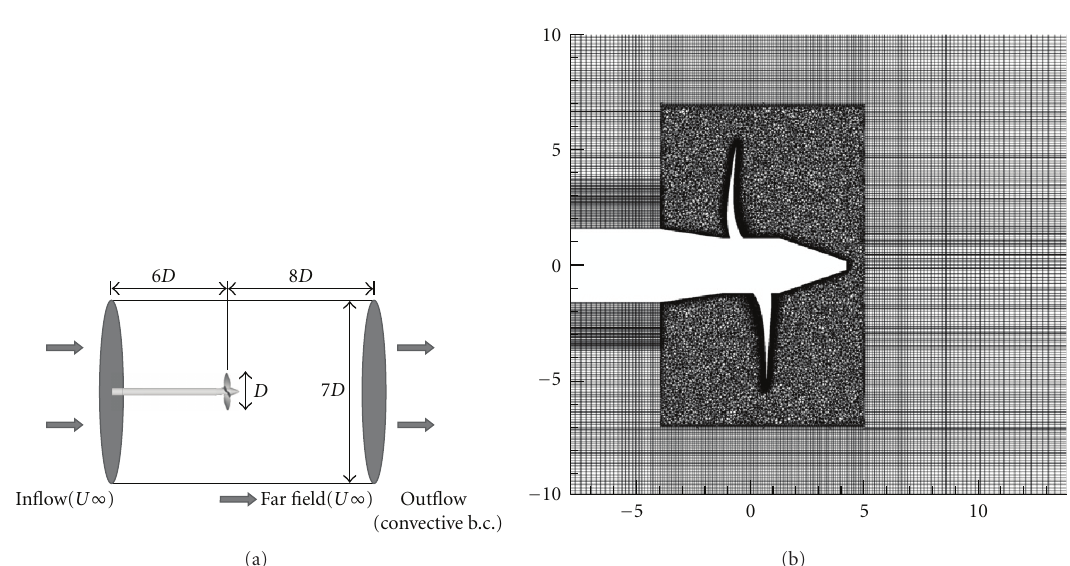
Figure 3: (a) Computational domain and boundary conditions on domain boundaries, (b) computational grid of open propulsor.